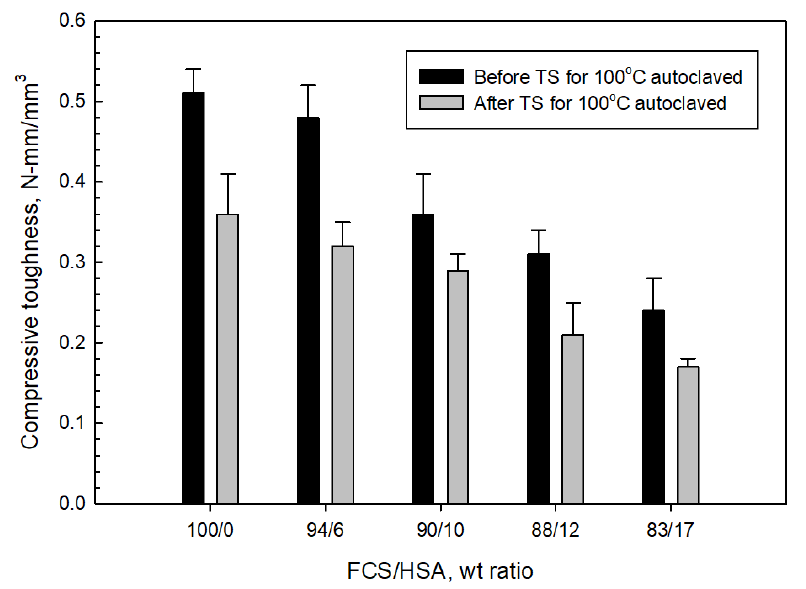
Figure 29. Compressive toughness of 100 °C-autoclaved CaP cements made with different FCS/HSA ratios before and after thermal shock (TS) tests.